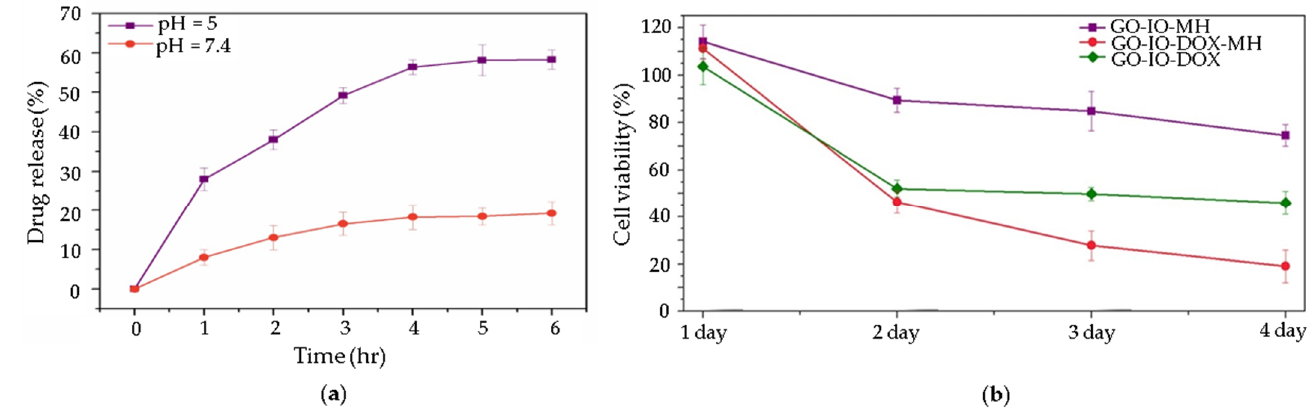
Figure 5. ( a ) pH dependent release of DOX from GO-IO-DOX over time; ( b ) effect of repeated periodic hyperthermia (15 min/24 h) on the CT26 cell line, used as cancer model. Reprinted from ref. [20].